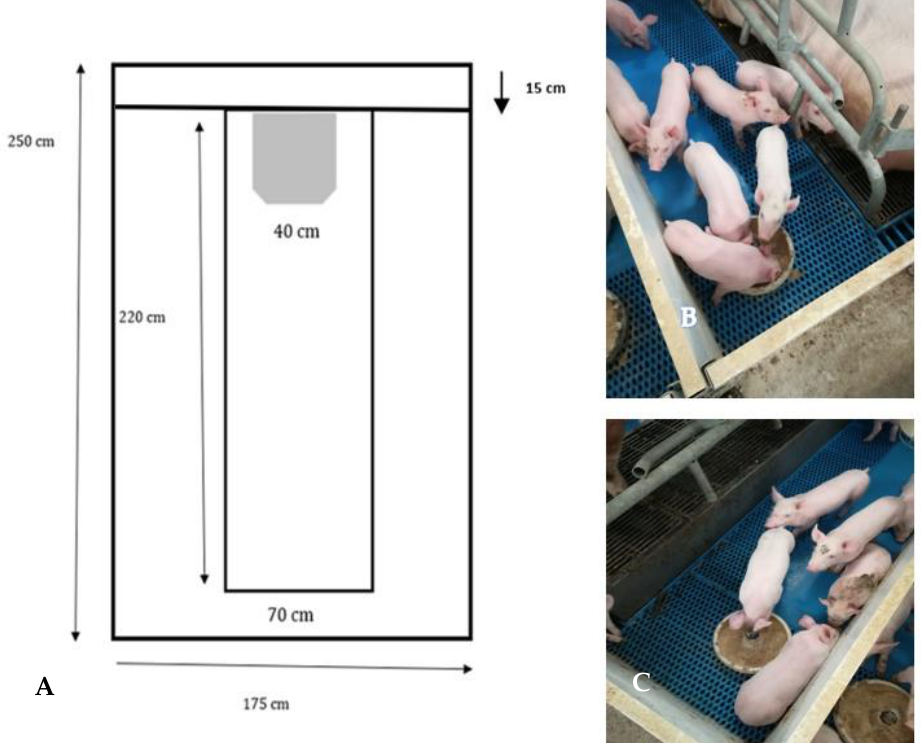
Figure 1. ( A – C ) Design and photos of the lift farrowing crate (LC).